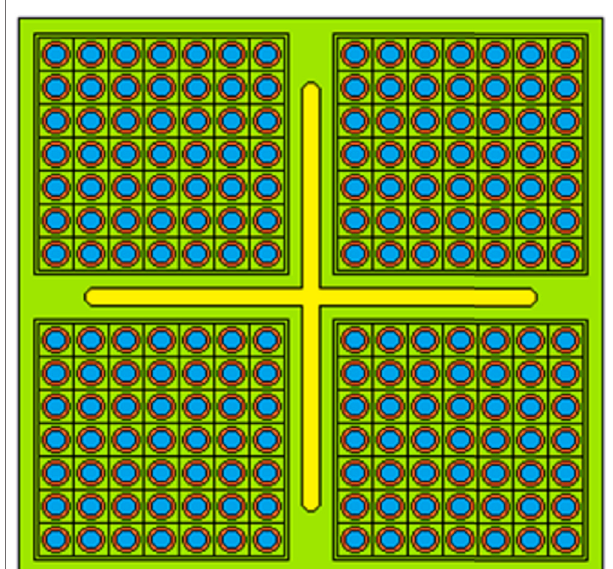
FIGURE2| ThesquarelatticeinthecoreofthedesignedBWRsystemin